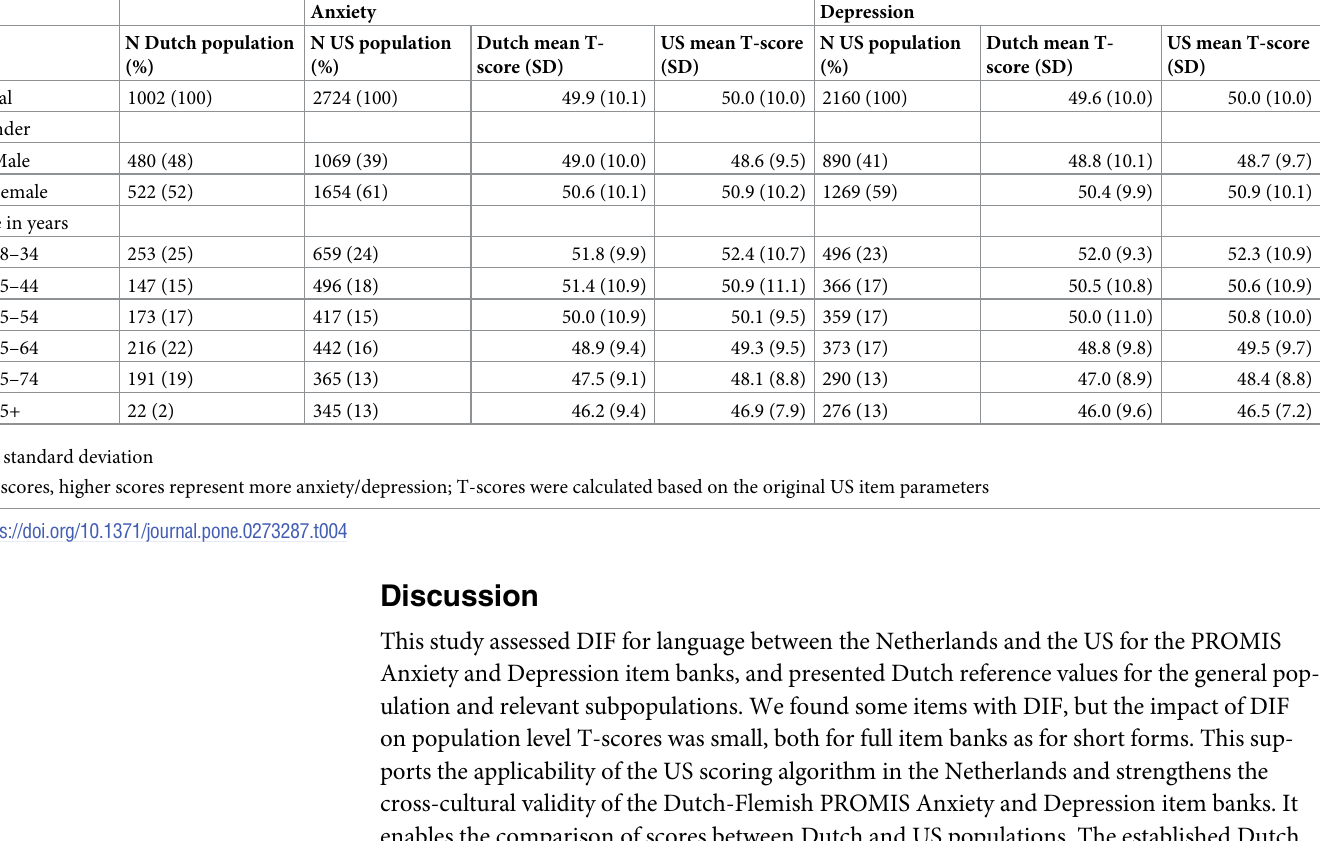
Table 4. PROMIS anxiety and depression Dutch reference values a by age and gender and comparisons with the US general population [58]. Anxiety Depression